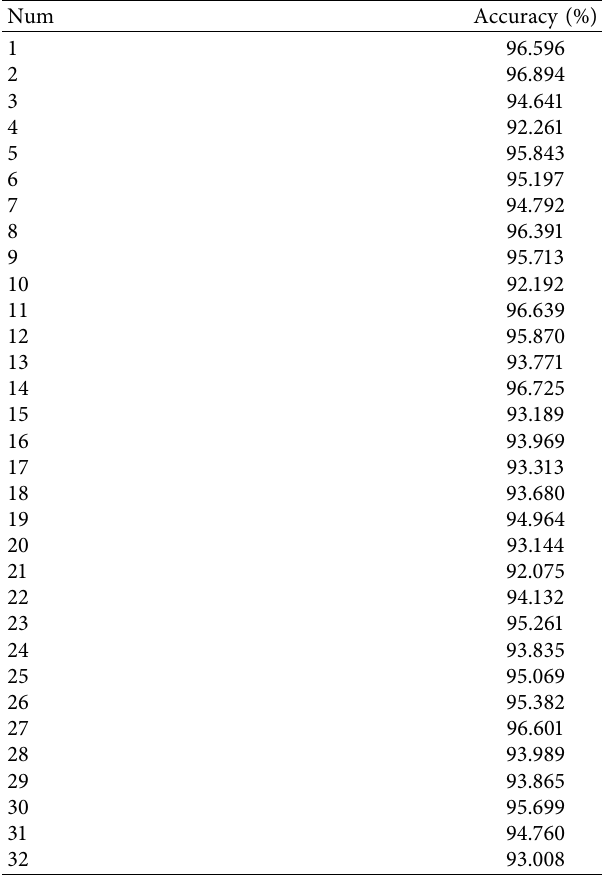
Figure 10: Recognition of musical features of trombone performance. (a) Performance section loudness and (b) schematic diagram of energy change and note onset. Table 1: Accuracy of trombone timbre feature extraction based on the CNN